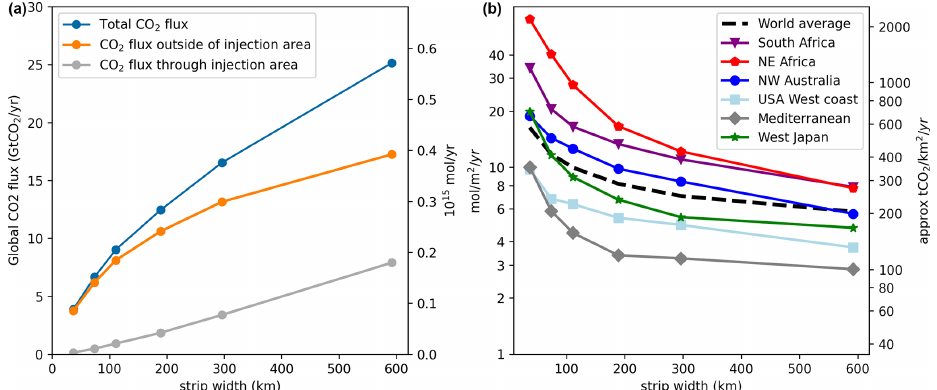
Figure 2. (a) Total CO 2 flux (GtCO 2 yr − 1 ), subject to (cid:49) pH tgt = 0 . 1, broken down into flux through the injection area and outside of the injection area. (b) Dependence of the averaged injection flux (molm − 2 yr − 1 ) on the width of the coastal injection strip for different coastal regions and strip widths. The black dashed line averages all coastal regions.